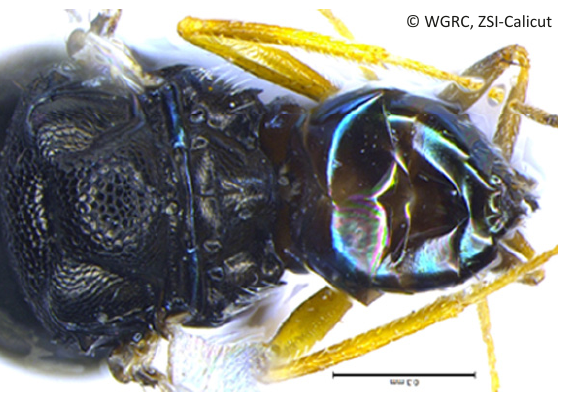
Image 5. Psilocera keralensis sp. nov. Body in part dorsal view.